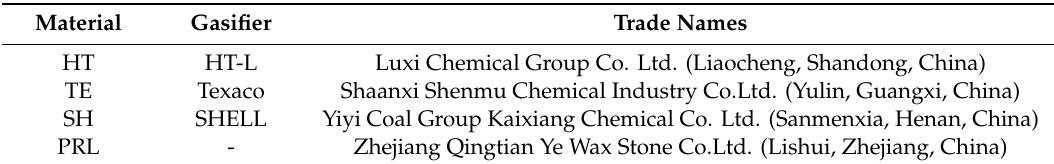
Table 1. Source of raw